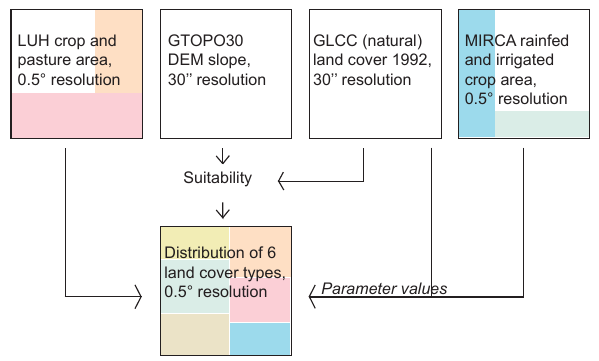
Figure 2. Schematic of how land cover parameters are constructed. Each block represents a 0.5 ◦ × 0.5 ◦ grid cell. LUH refers to harmo- nized land use data from Hurtt et al. (2011), DEM refers to digital elevation map (Van Beek et al., 2011), GLCC is the Global Land Cover Characterization (Olson, 1994a, b; Hagemann et al., 1999) and MIRCA refers to Monthly Irrigated and Rainfed Crop Areas (Portmann et al., 2010). After Dermody et al.